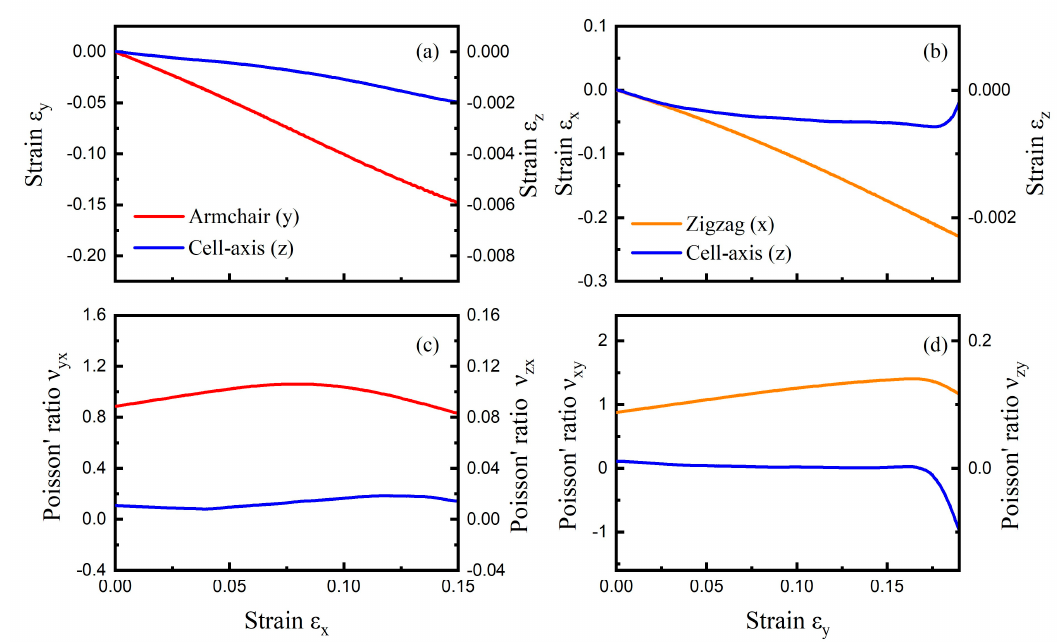
Figure 2. Normal to auxetic (NA transition) in carbon honeycomb (CHC). Engineering strain ε y and ε z versus ε x curves for CHC subjected to uniaxial tensile tests in the zigzag direction ( a ), and in the armchair direction ( b ). The accompanying ν for tensile tests in the zigzag direction ( c ), and armchair direction ( d ). The negative Poisson’s ratio is observed at about 0.168 strain when tensile strain was applied along armchair direction.